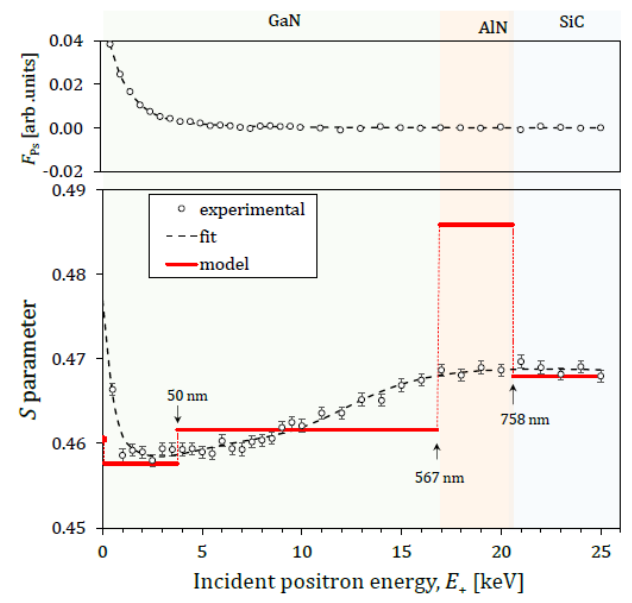
Figure 5. Plotted depth profiles S ( E + ) of GaN/SiC. The experimental errors are in the order of the experimental point size. The stairs represent the best parameters obtained by the fit of a 4-layer model to the experimental data by the VEPFIT software. The values represent the cumulative thickness of the layers. The upper part of figure is the experimental data and the best fit of the relative Ps fraction, F Ps ( E + ).